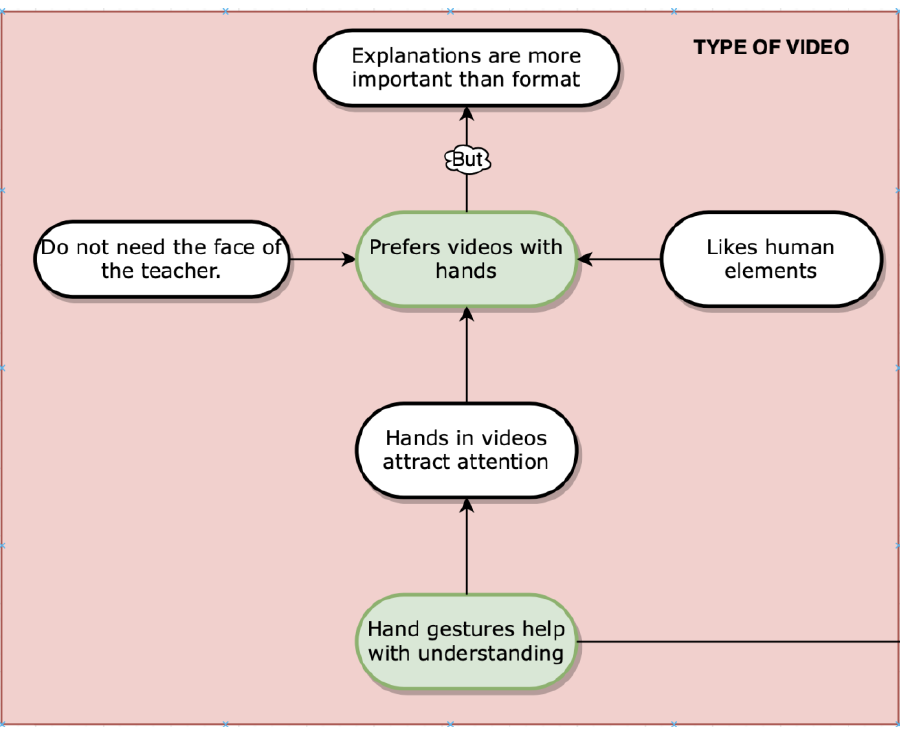
Figure 5. Enlargement of the box “type of video”. What makes hand gestures help with understanding is that they attract